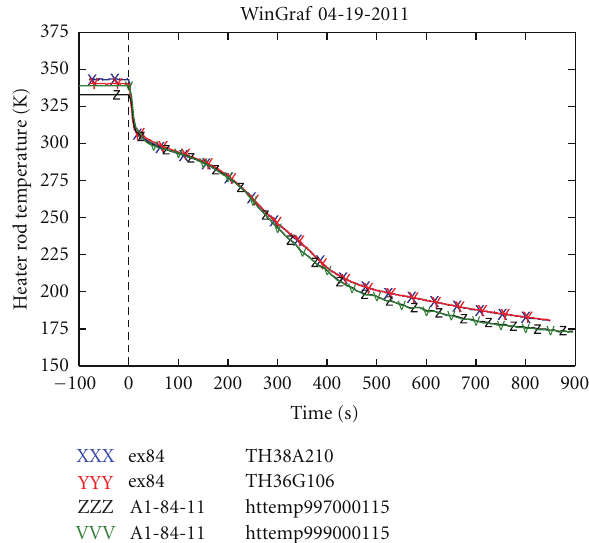
Figure 26: Cladding temperature, middle- and top-heated length level.